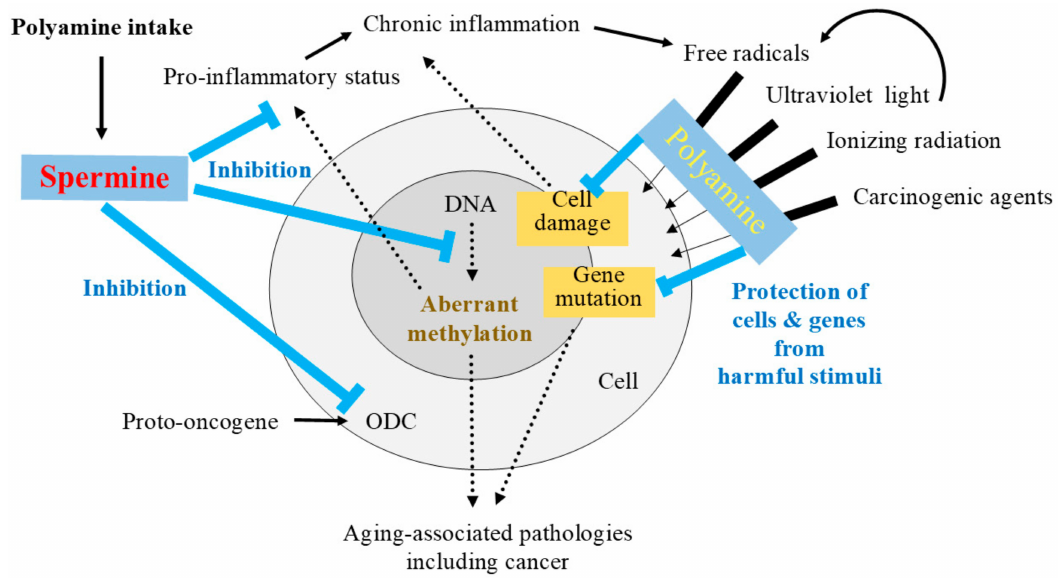
Figure 4. The role of spermine in the inhibition of aging-associated pathologies. Increased polyamine intake elevates spermine levels. Spermine is converted to spermidine by spermidine/spermine N 1 -acetyltransferase (SSAT) and N 1 -acetylpolyamine oxidase (APAO). Increased polyamines (spermine